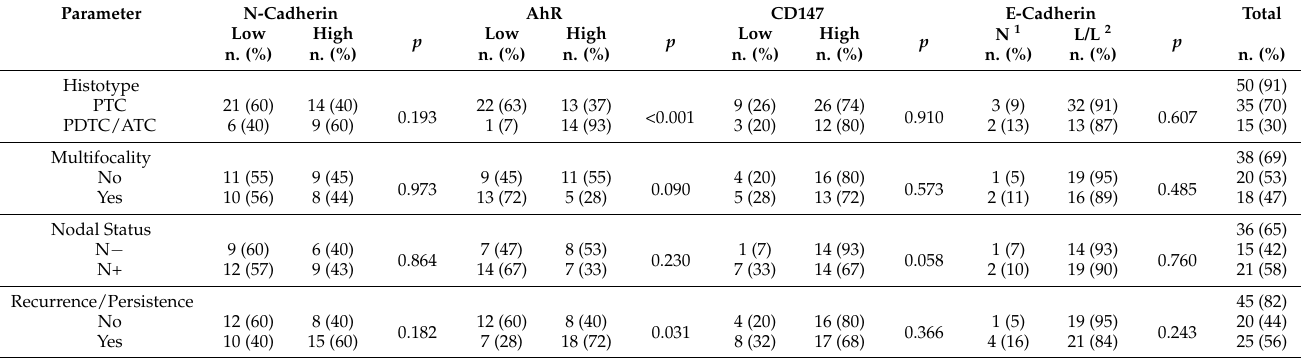
Table 5. Expression of N-cadherin, AhR, CD147 or E-cadherin associations with clinical–pathological characteristics. Parameter